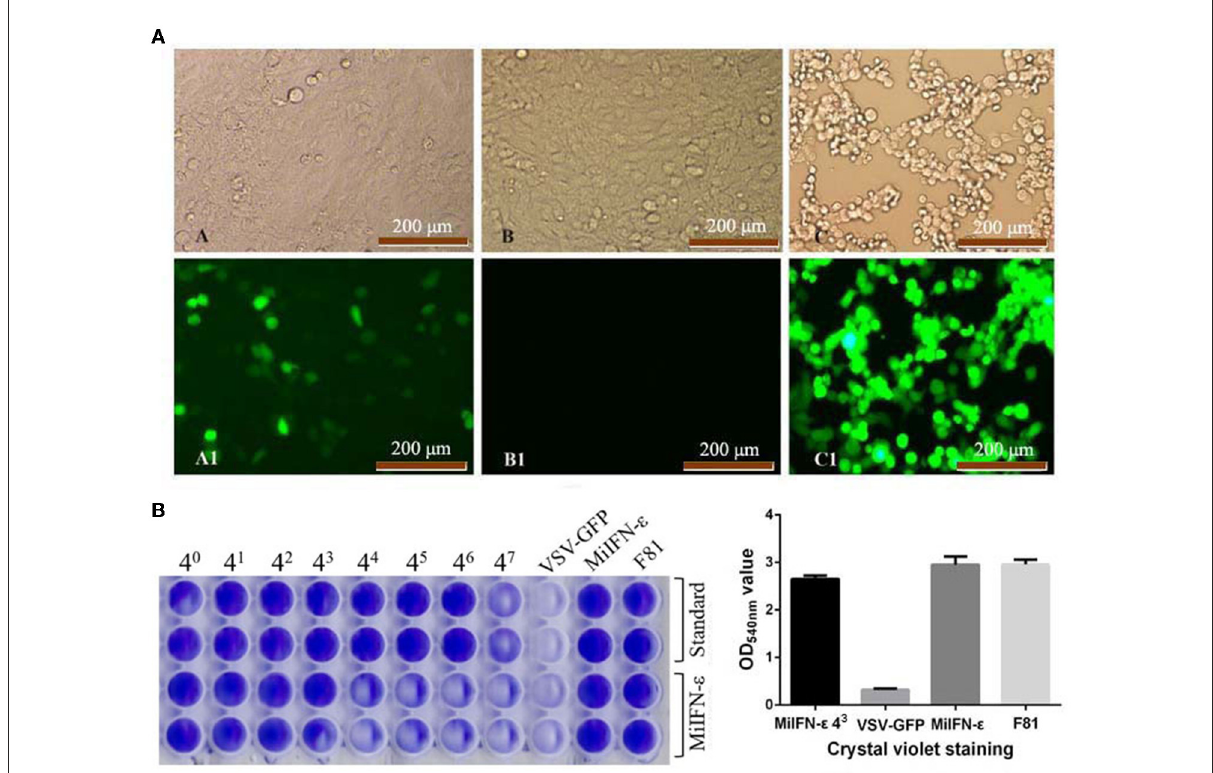
FIGURE6 Fluorescence and crystal violet staining results of the inhibition of the replication of vesicular stomatitis virus tagged with green fluorescent protein (VSV-GFP) in Feline kidney 81 (F81) cells at 48h. (A) A and A1, INF- ε 4 3 Dilution; B and B1, Normal cell control; C and C1, VSV-GFP control. (B) Optical density at 540nm after crystal violet staining.